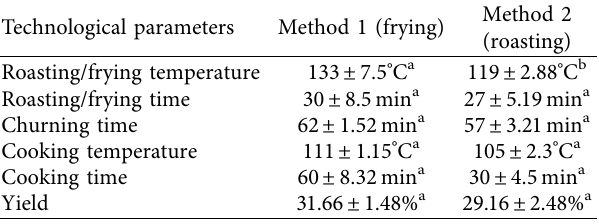
Table 1: Technological parameters for the production of Penta- desma butter in a traditional environment ( n �